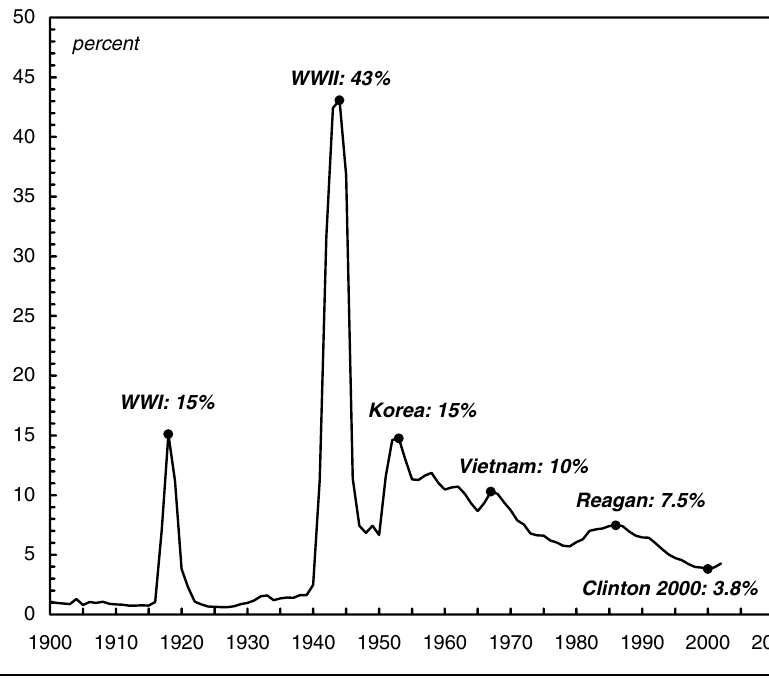
Figure 16 – U.S. Military Spending as a Share of